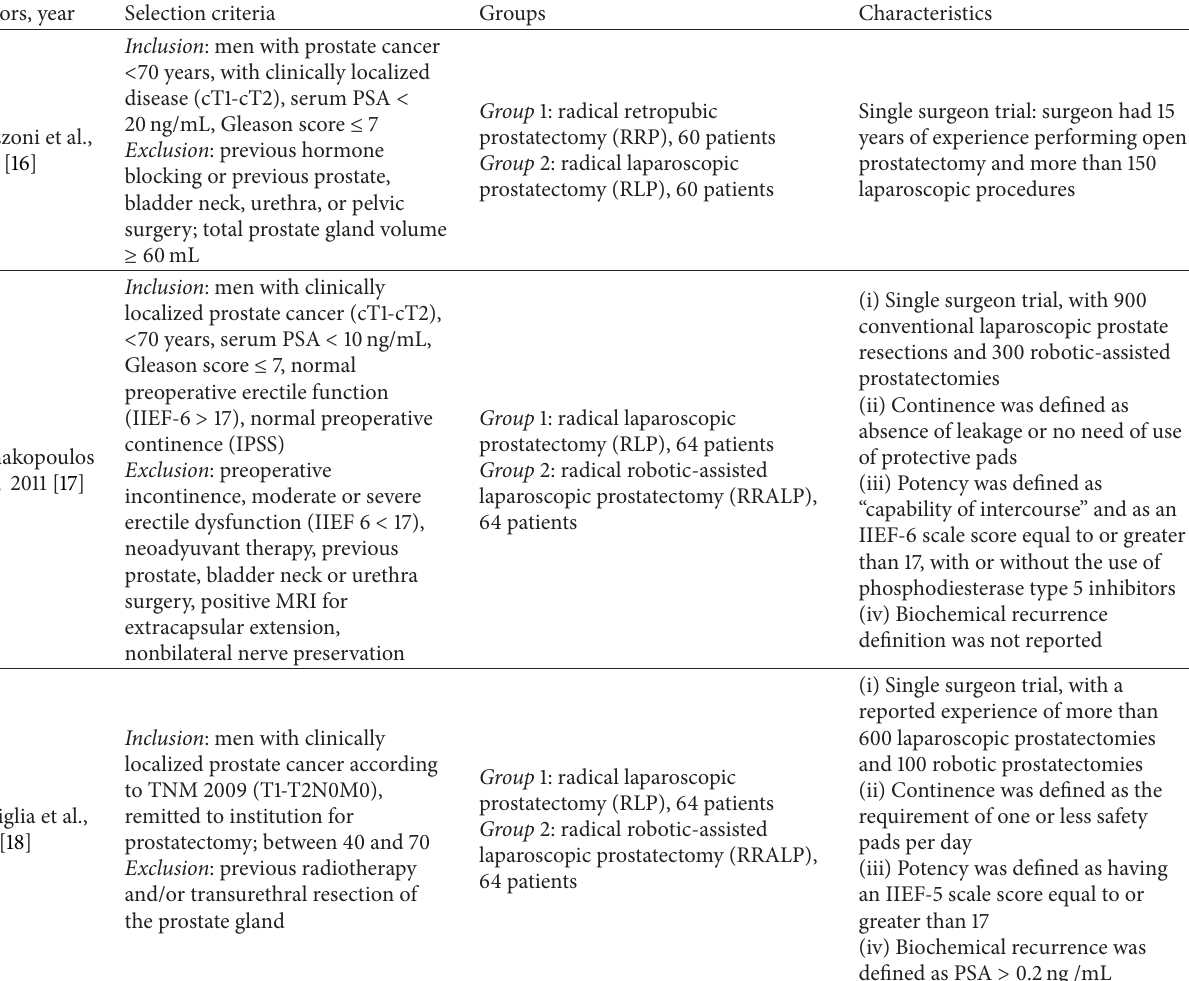
Table 1: Characteristics of studies included in the